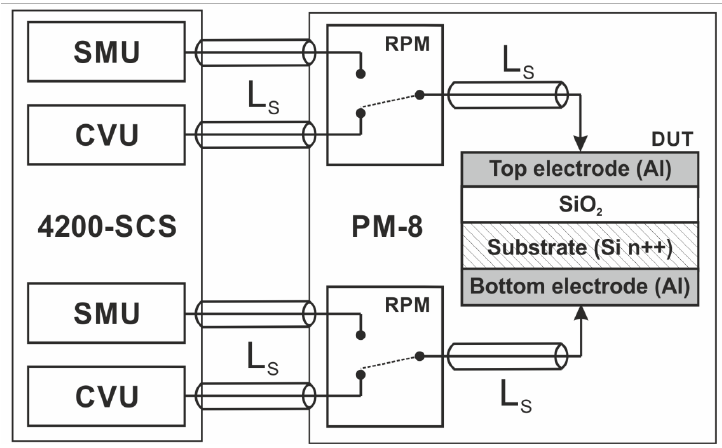
Figure 2. Measurement setup used to characterize fabricated structures.